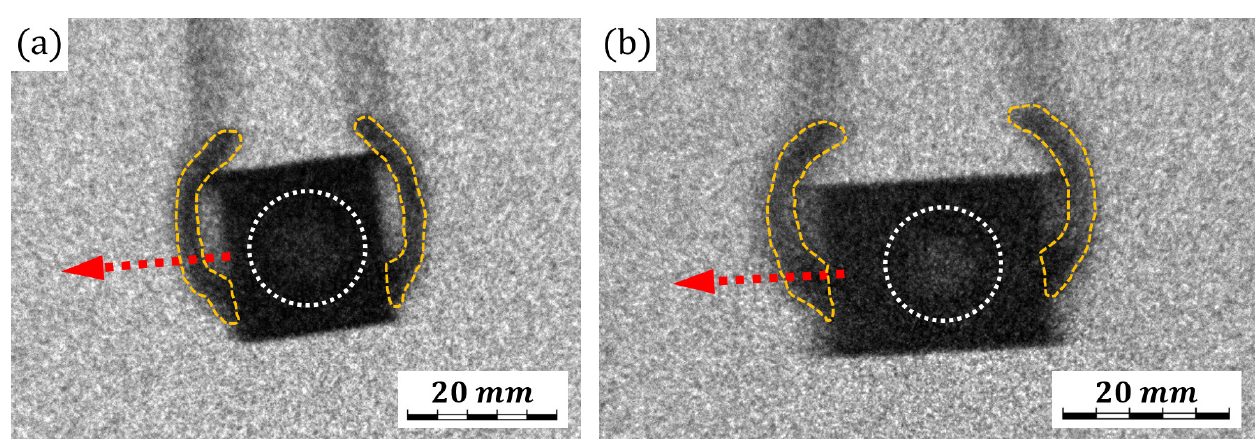
Figure 22. Neutron radiography image of the pendulum used for the reference experiments with the moving reference body: neutron flux transmission along the ( a ) longer and ( b ) shorter axes. The red dotted arrows indicate the direction of motion and the white dotted circles highlight the locations of the spherical void. The pendulum arm is a standard lab holder and the reference body is held by clamps (dashed orange lines). Note the motion blur visible at the body boundaries and the holder arms above the